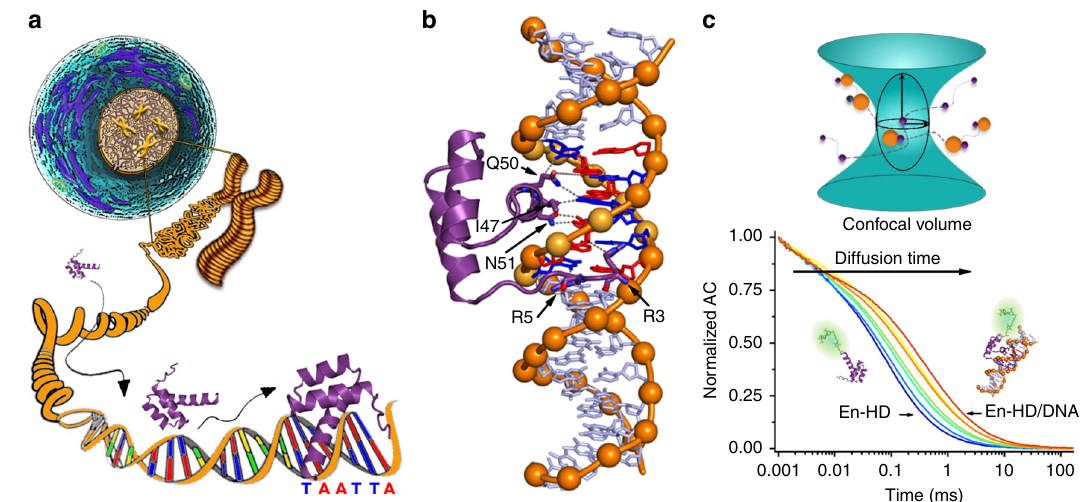
Fig. 1 EngHD binding to the target speci fi c site. a Pictorial representation of the challenges involved in tracking the target cognate site in the genomic DNA of a eukaryotic cell. b 3D Structure of the speci fi c complex between EngHD and DNA (PDB: 1HDD). c Schematic diagram of how to determine binding of EngHD to DNA using FCS. (top) The miniscule illumination volume of a confocal microscope is used to monitor fl uctuations in the emission of fl uorescent-labeled EngHD molecules (purple) while in diffusive transit. When bound to the much larger DNA molecule (orange), EngHD experiences delayed diffusion, staying longer within the illumination volume. The fl uorescence autocorrelation decay (bottom) represents the average diffusion, which depends on the fraction of free and bound EngHD molecules. FCS experiments at various concentrations of DNA permit to accurately determine the dissociation constant from the combined autocorrelation